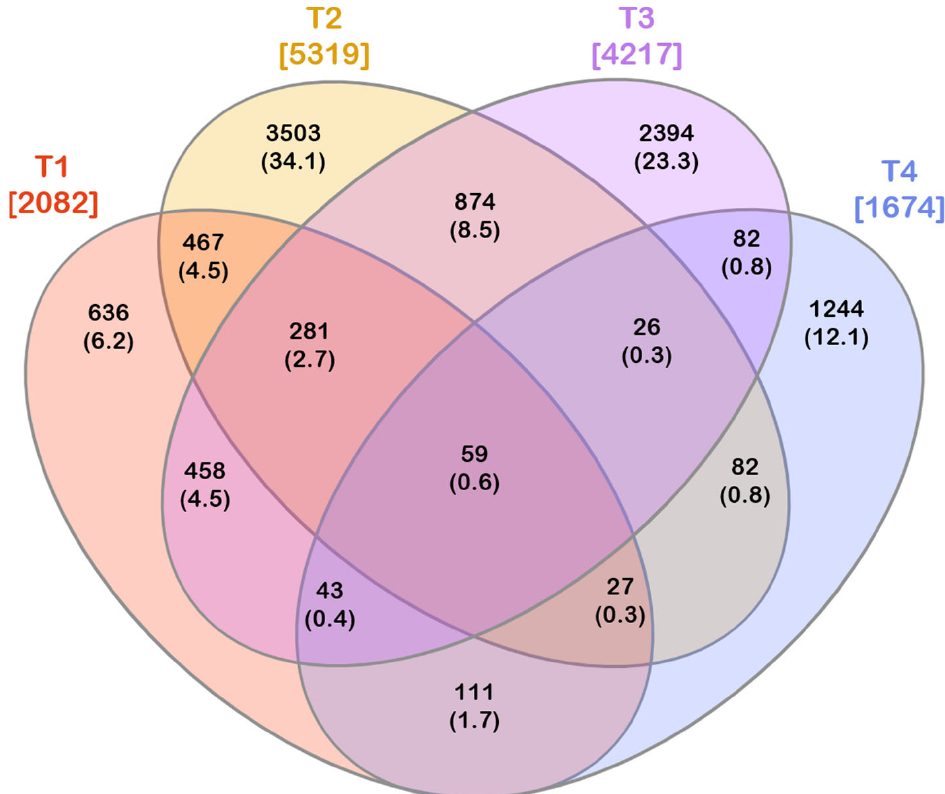
Figure 5. Venn diagram depicting the number of exclusive and shared OTUs among the investigated experimental conditions. The total number of OTUs found in each experimental condition is reported in square brackets. Both the number of exclusive/shared OTUs and the corresponding percentage (in round brackets) on the total of the OTUs are reported. T1: WT/OF, T2: WT/CF, T3: SB/OF, T4: